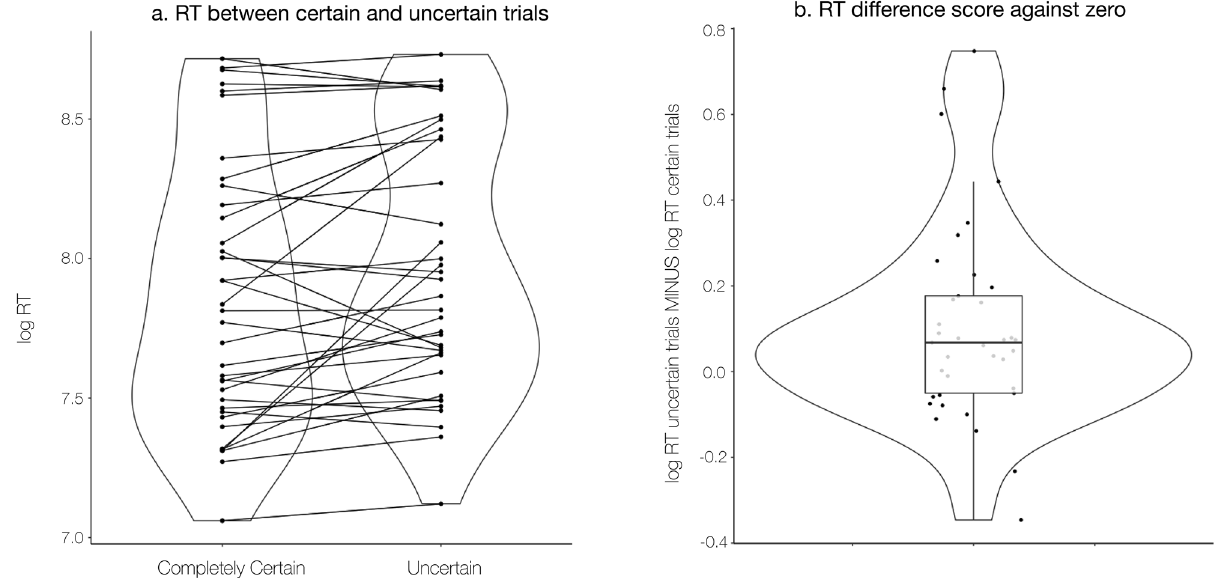
Figure 5. Differences in reaction time between certain and uncertain trials. Participants were quicker to rate pain during certain trials ( t (36) = 2.70, p = .01, CI = [.03, 0.18], mean difference = 0.11 log RT (RT in ms)). ( A ) We used violin plots to present participant’s mean log reaction time during certain trials (left violin plot; M logRT = 7.86 log RT, SD logRT = 0.48) and uncertain trials (right violin plot; M logRT = 7.96 log RT, SD logRT = 0.45) and lines to indicate change in reaction between certain and uncertain trials for each participant. ( B ) We present participant difference scores ( M difference score = 0.10, SEM difference score = 0.038), computed by subtracting the mean reaction time during certain trials from the mean reaction time during uncertain trials for each participant. A boxplot shows the median difference value ( Median difference score = 0.07) and interquartile range ( IQR = 0.23; Q1 : − 0.05, Q3 : 0.18).